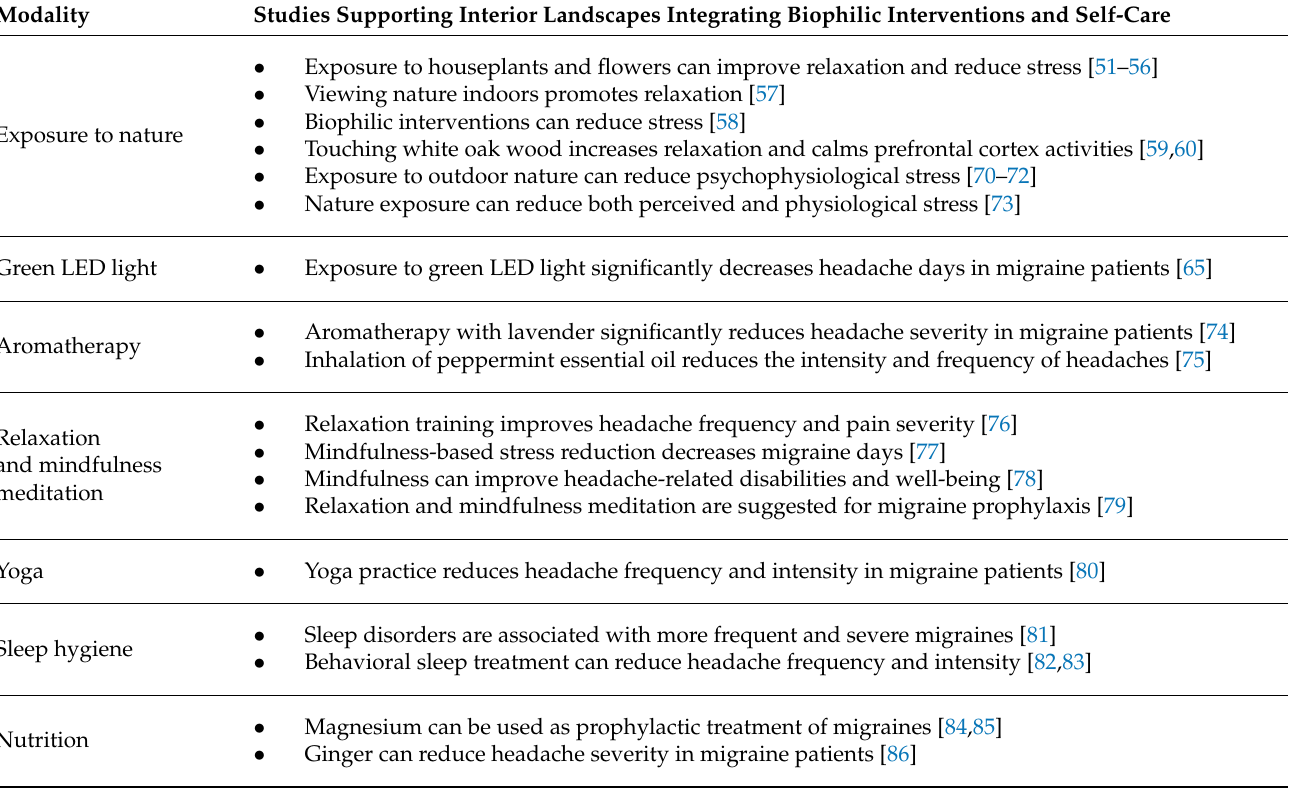
Table 1. Research evidence on incorporating biophilic interventions and self-care modalities into therapeutic interior environments for people with